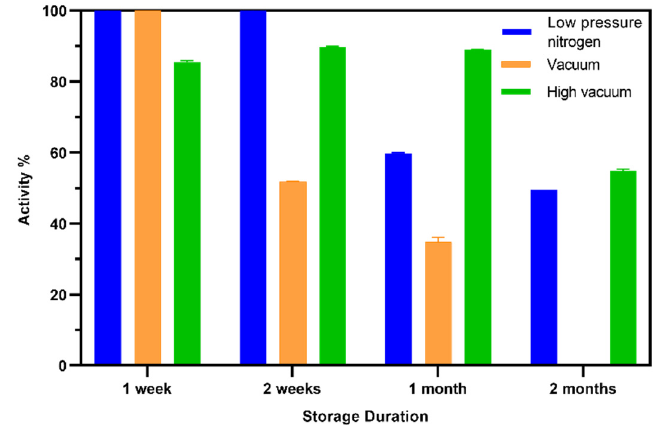
Figure 7. Shelf-life test of the TEMPO-CNC glucose sensor under different storage conditions: low-pressure nitrogen (400 mbar N 2 ), vacuum ( ≤ 50 mbar), and high-vacuum ( ≤ 10 mbar) drying treatment before vacuum packing ( ≤ 50 mbar). All sensors were stored at 4 °C. The sensors were tested after 1 week, 2 weeks, 1 month, and 2 months. All values are normalized against the signals of sensors tested without storage.